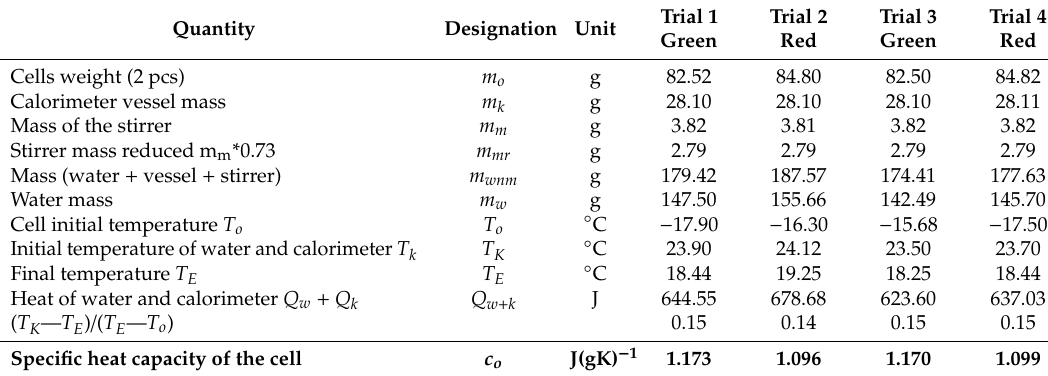
Table 1. Measurement values and the obtained result of specific heat for two types of cells. Water as a heating medium.